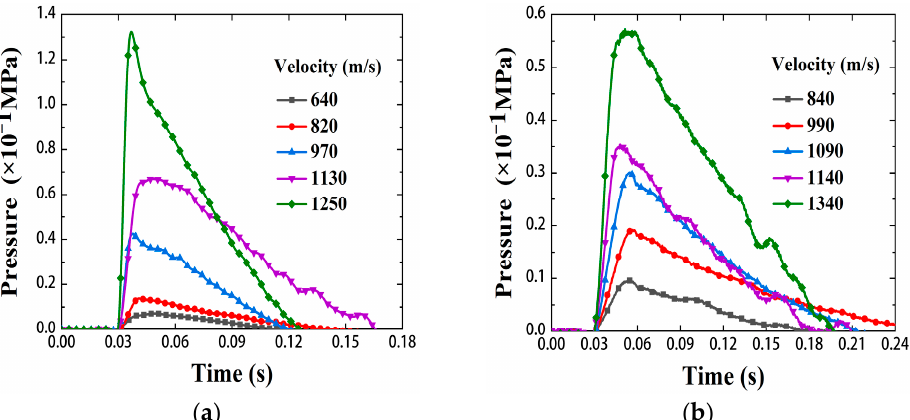
Figure 9. Quasi-static pressure-time curves in the chamber for the Zr/PTFE, Ti/PTFE. ( a ) Zr/PTFE. ( b ) Ti/PTFE. ( b )